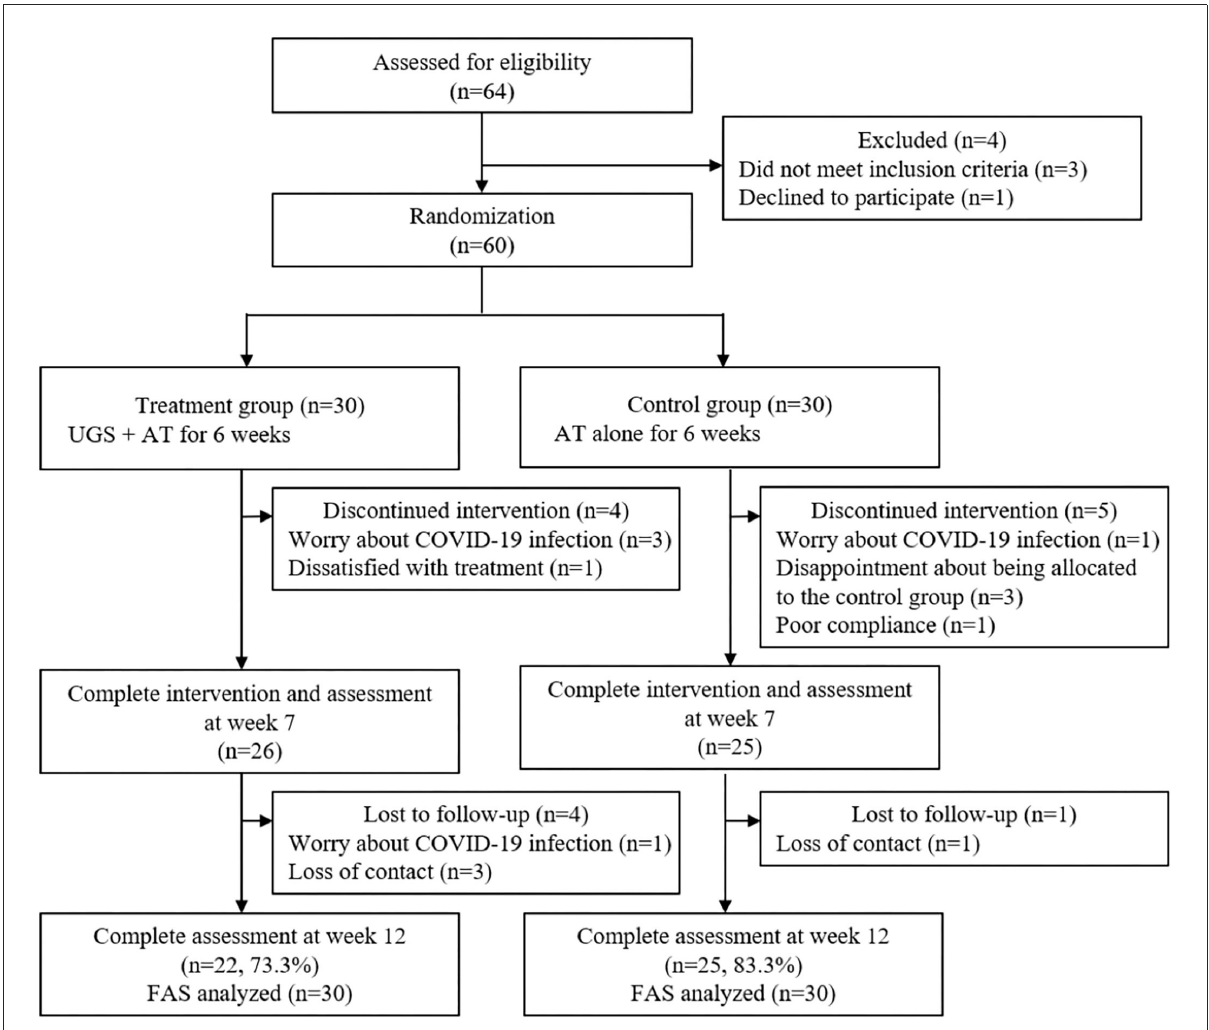
FIGURE2 Study flow diagram. UGS, Ukgansan; AT, acupuncture; COVID-19, coronavirus disease